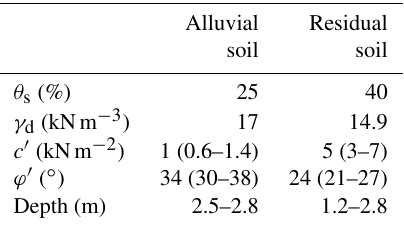
Table 1. Geotechnical parameters of La Arenosa catchment from laboratory tests. γ d = specific weight dry of soil, c (cid:48) = effective co- hesion, ϕ (cid:48) = effective angle of internal friction and θ s = saturated water content minimum and maximum values for c (cid:48) and ϕ (cid:48) are pre- sented. Alluvial Residual soil